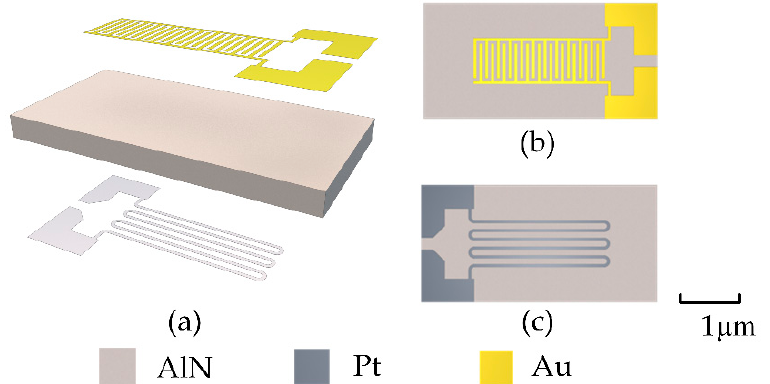
sign. To further reduce the diffusion of heat to the sides, we make through-holes 1650 μ m in length and 250 μ m in width on both sides of the heating plate. The left and right sides in Figure 2c,d. Figure 1. First proposed design using AlN as the substrate. Electrodes are placed on both sides of the substrate. ( a ) Decomposition of the structure, ( b ) front side, and ( c ) back side. The second design option uses a sandwich-like three-layer structure design, as shown in Figure 2a,b, with the electrodes originally arranged on either side of the base on the front. This arrangement brings the heating resistor closer to the interdigital electrodes, which can significantly improve the heating efficiency and reduce the power consump- tion. To insulate the interdigital electrodes from the heating resistor, we decided to use AlN, which has excellent thermal conductivity, as a spacer layer. The AlN acts as an elec- trical insulator while conducting the heat from the heating resistor to the upper interdig-